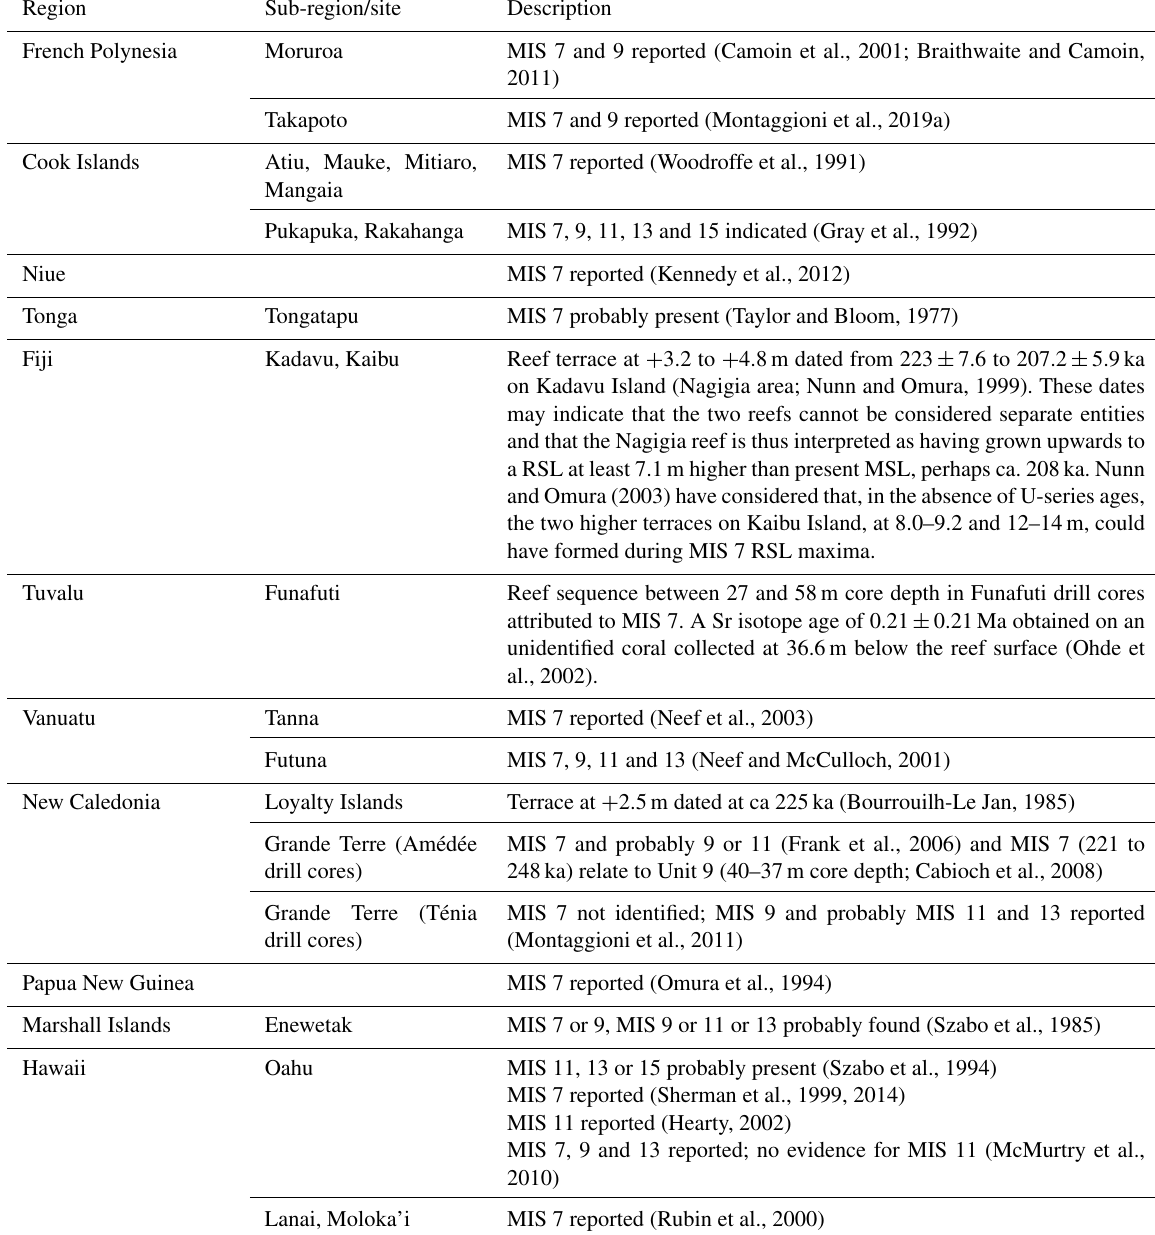
Table 6. Other interglacials reviewed in this study.